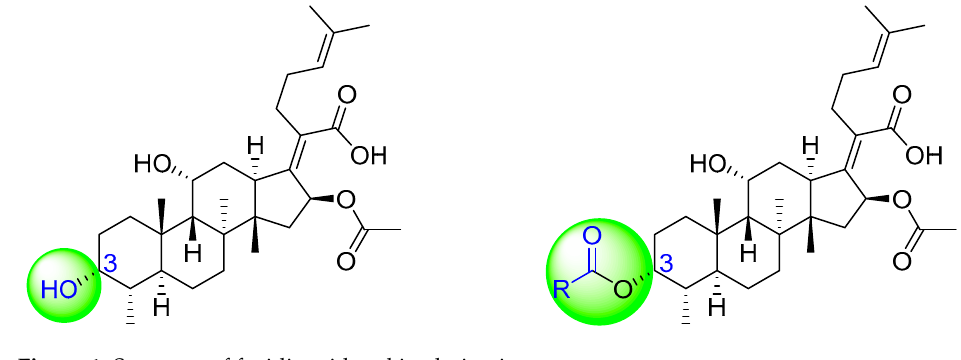
Figure 1. Structure of fusidic acid and its derivatives.